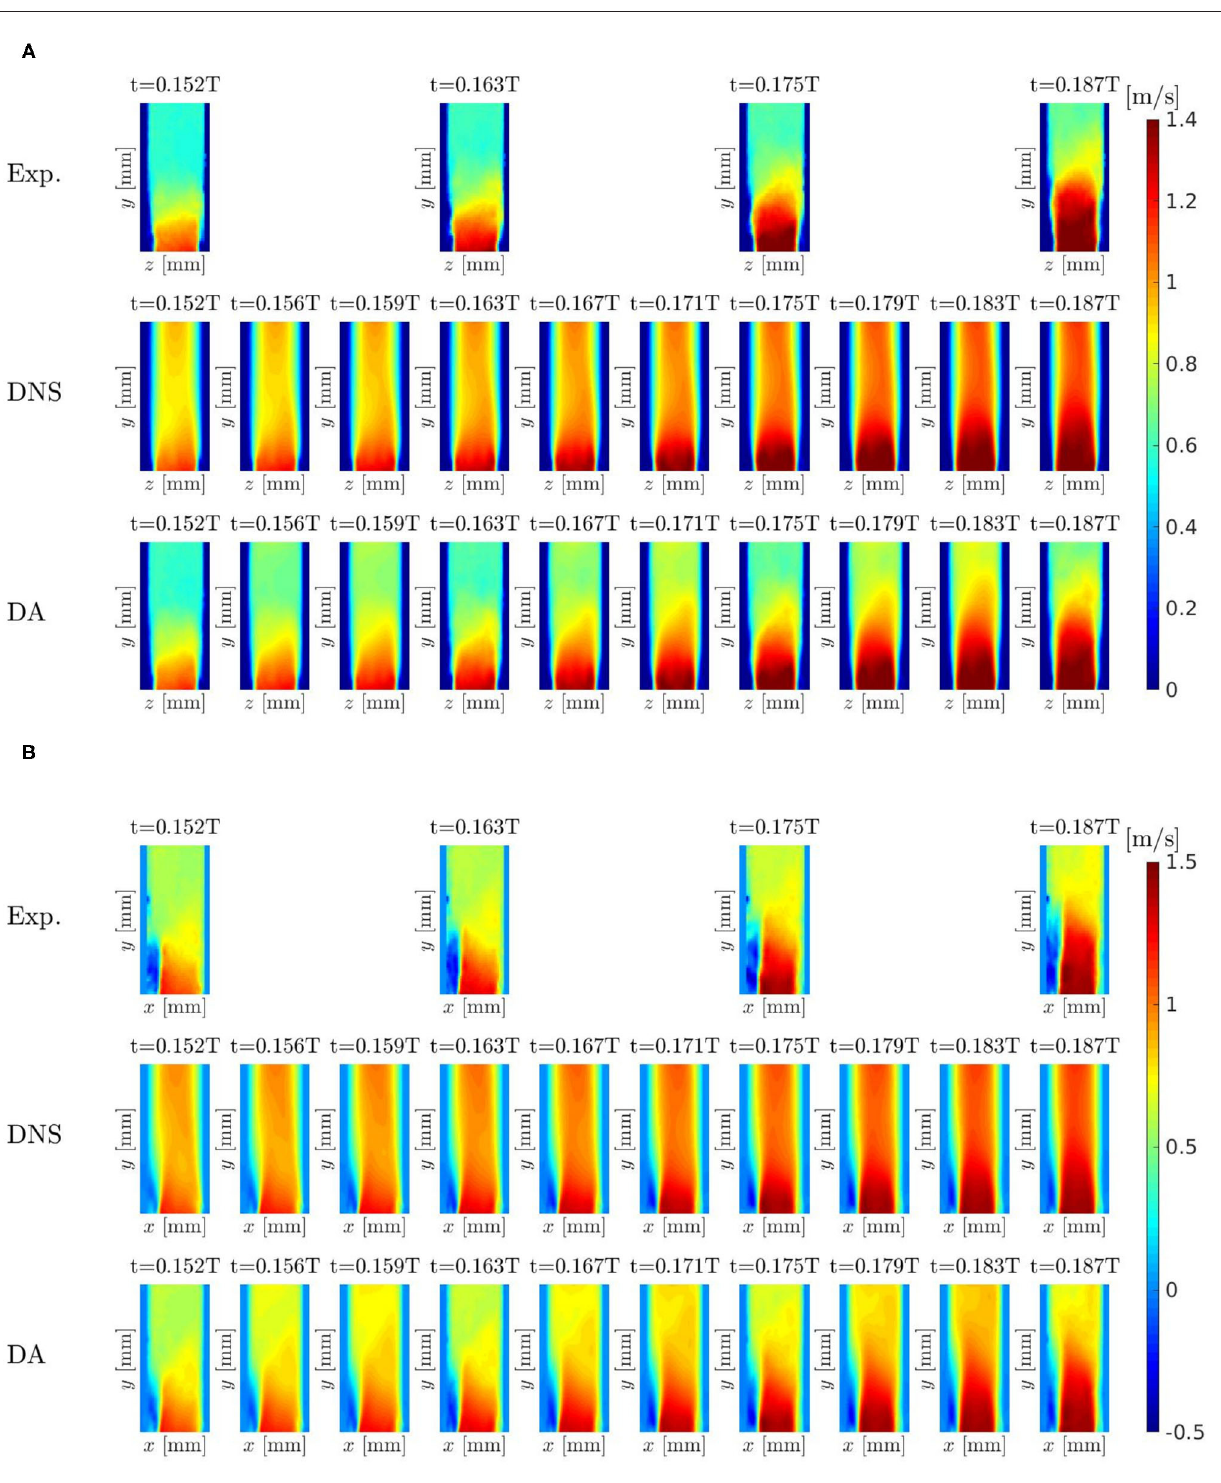
Frontiers in Cardiovascular Medicine |